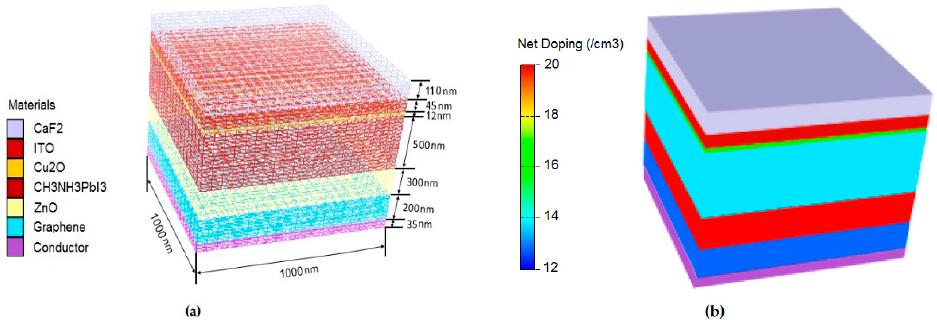
Figure 2. ( a ) Meshed structure (mode transparent), and ( b ) net doping concentration of the inverted planar